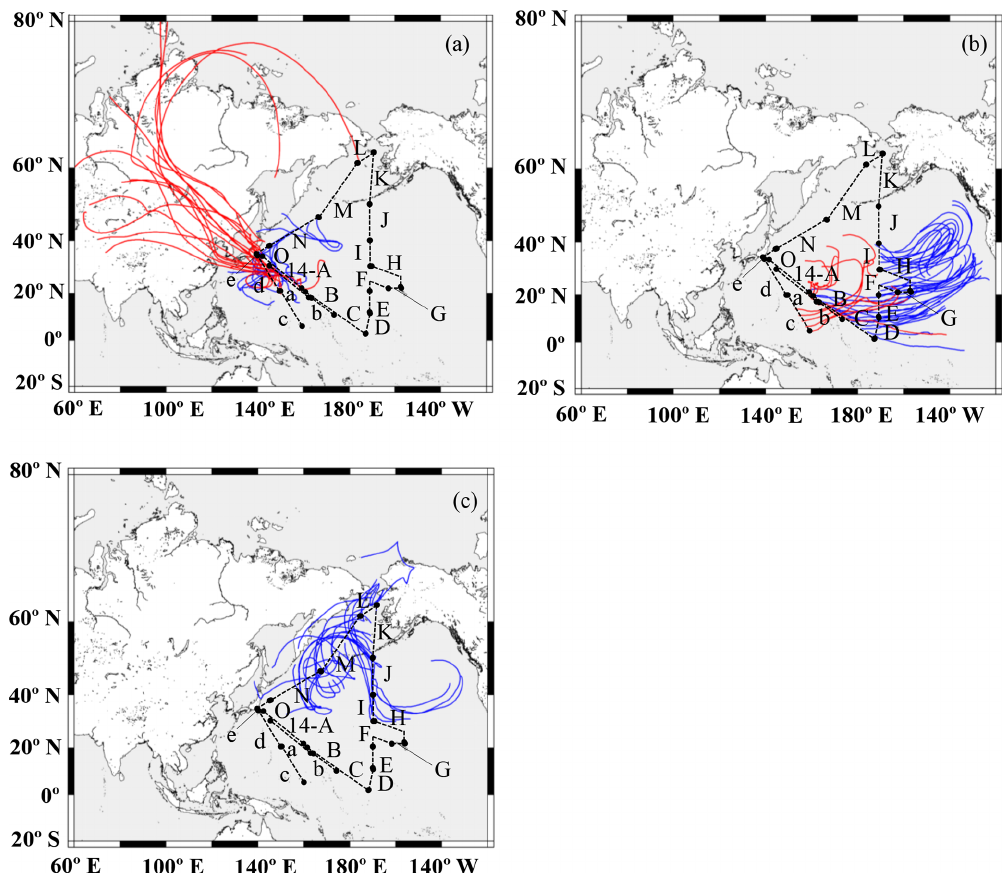
Figure 2. The 7d backward trajectories along the ship tracks for (a) group I, (b) group II, and (c) group III. The arrival height was set to 500m, and a new trajectory was obtained every 12h. The maps were created using GMT. Red and blue lines indicate trajectories during the KH-13-7 and 14-3 cruises,